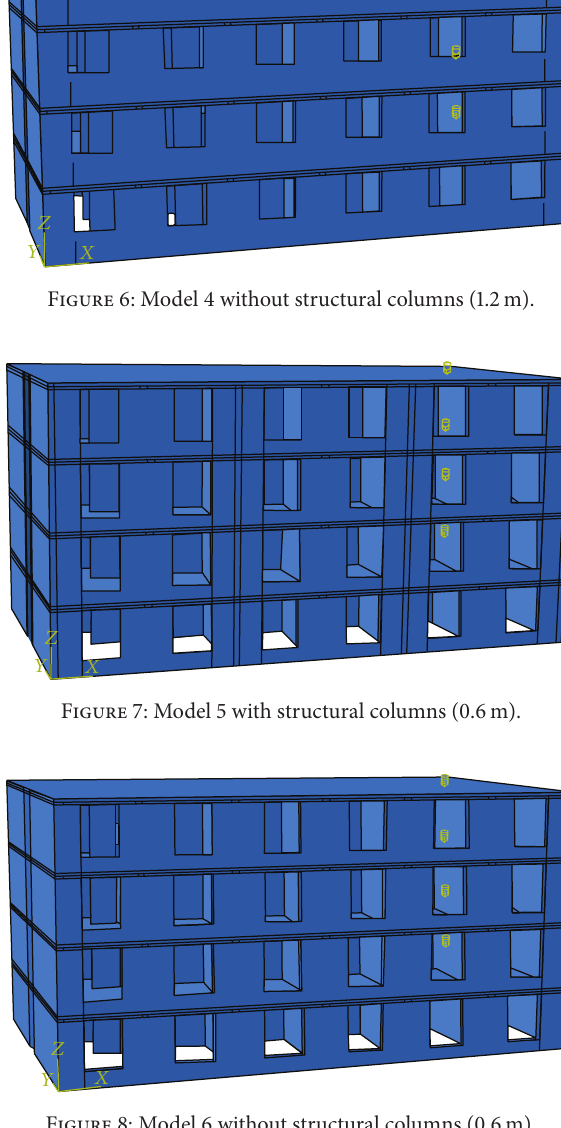
Figure 8: Model 6 without structural columns (0.6